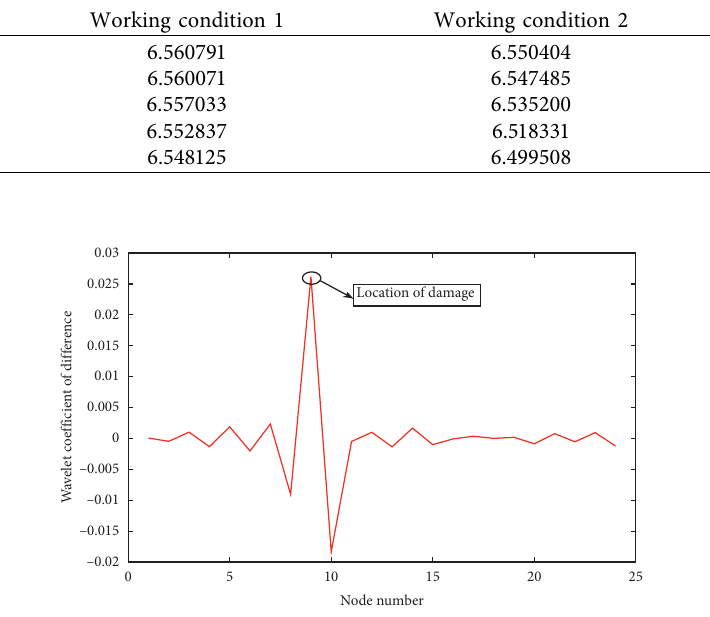
Figure 3: Wavelet coefficient difference graph for 5% damage in section 9.